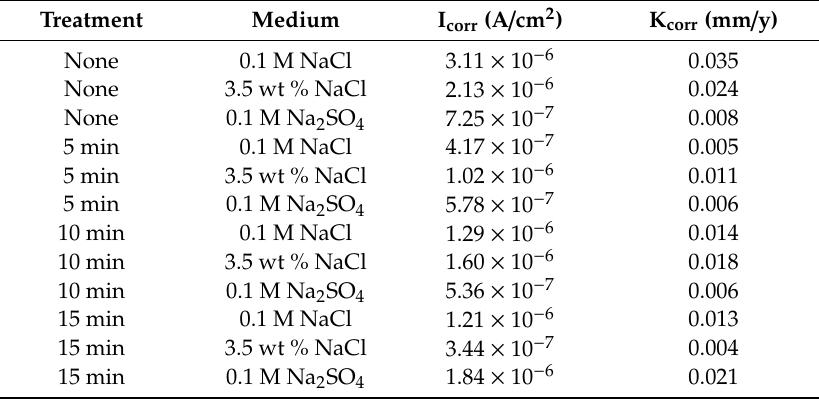
Table 2. Tafel analysis and corrosion